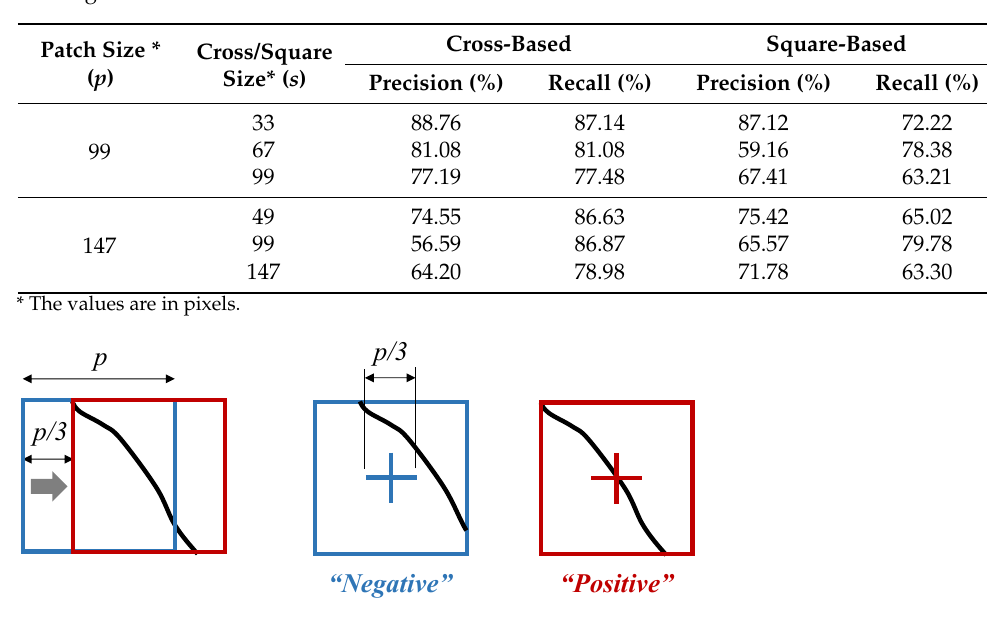
Table 4. Precision and recall of classifying crack patches depending on the patch sizes and labeling standards.